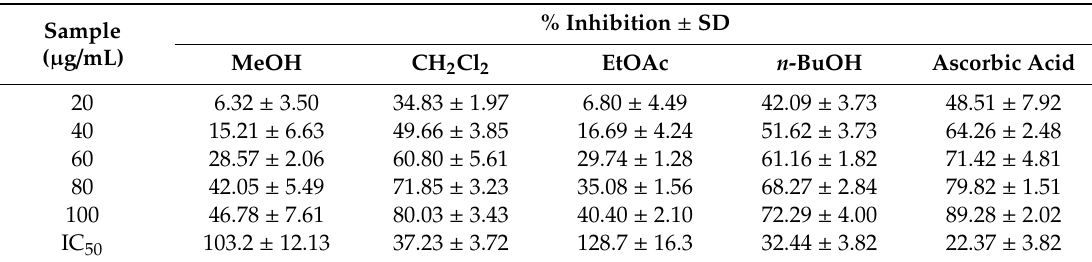
Table 5. Antioxidant e ff ect of thee A. vacillans extract using nitric oxide